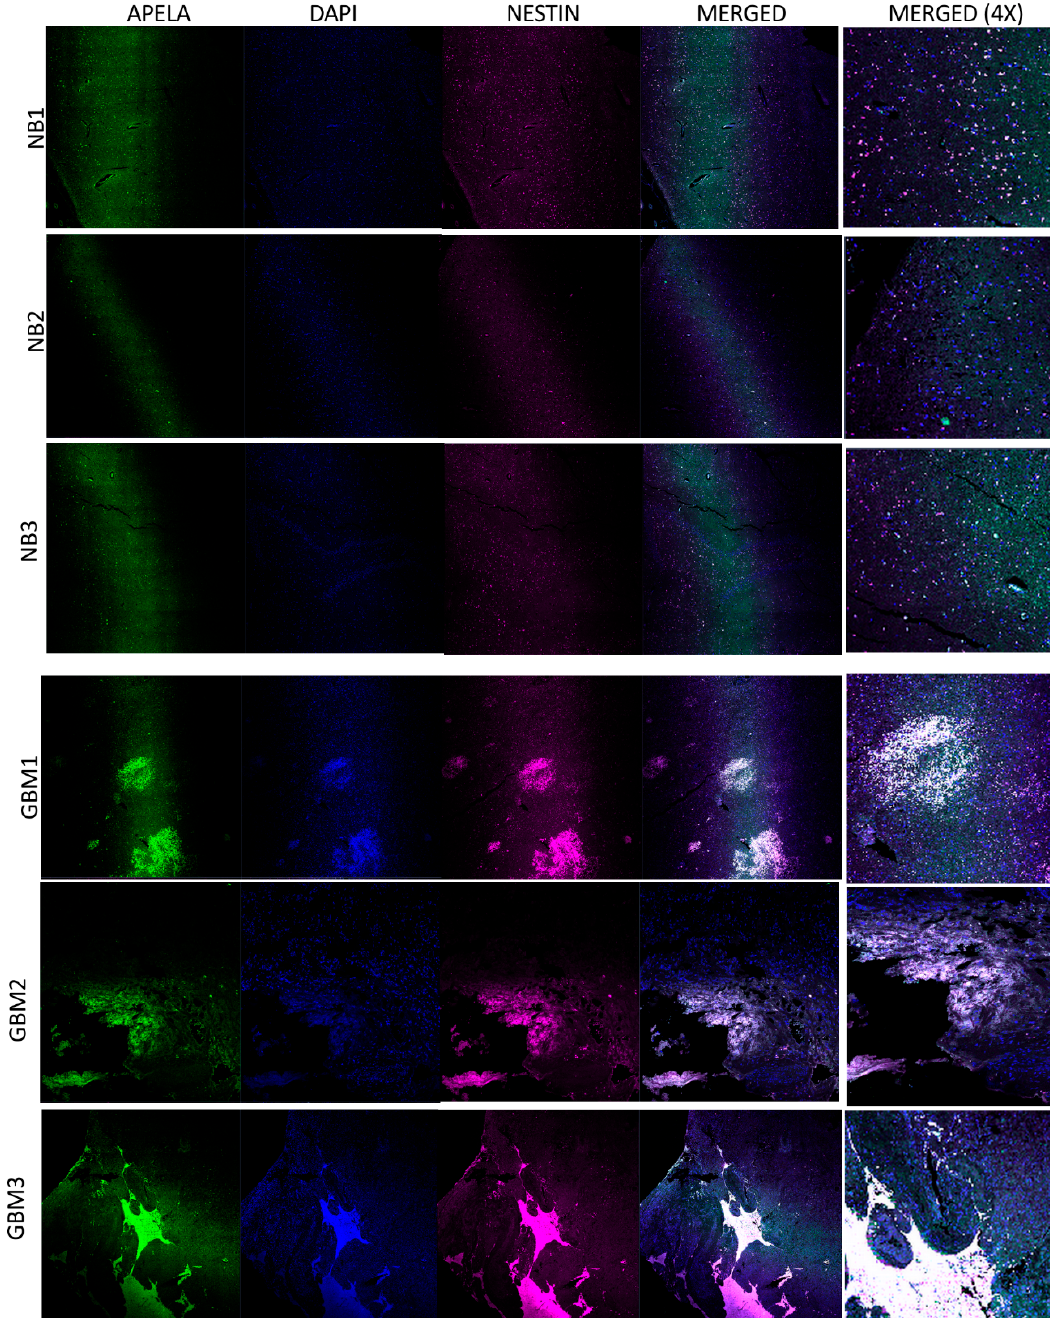
Figure 3. IHC for APELA protein expression in normal brain and glioma samples. IHC was performed on FFPE blocks of normal brain (NB) and GBM tumor tissue using anti-APELA and anti-Nestin Ab and processed for IHC. Representative images are shown.